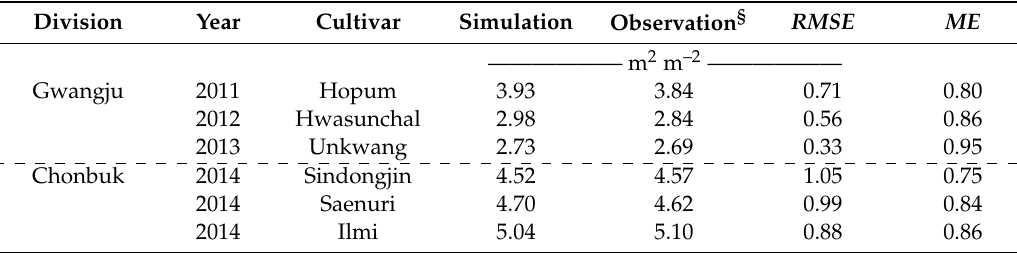
Figure 4. Simulated (S) and observed (O) leaf area index (LAI) and simulated above ground dry mass (SAGDM) of Hopum in 2001 ( a ), Hwasunchal in 2012 ( b ), and Unkwang in 2013 ( c ), and a comparison between simulated (Sim) and observed (Obs) yields ( d ) at Chonnam National University, Gwangju, S. Korea for model verification. Table 3. Comparisons between simulated and observed mean leaf area index (LAI) of paddy for model calibration at Chonnam National University (CNU), Gwangju and for model validation at Buan and Gimje, Chonbuk in South Korea. Comparison statistics applied were root mean square error (RMSE) and model efficiency ( ME ).